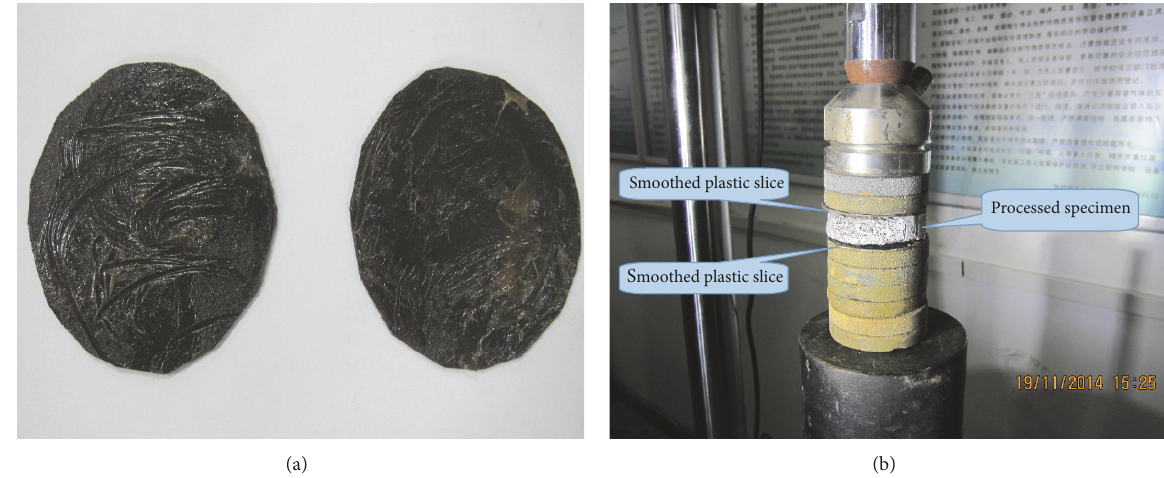
Figure 5: Smooth plastic slices (a) and uniaxial compression experimental system